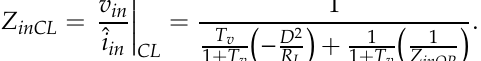
Figure 8. Bode plot of closed-loop input impedance at different T v .